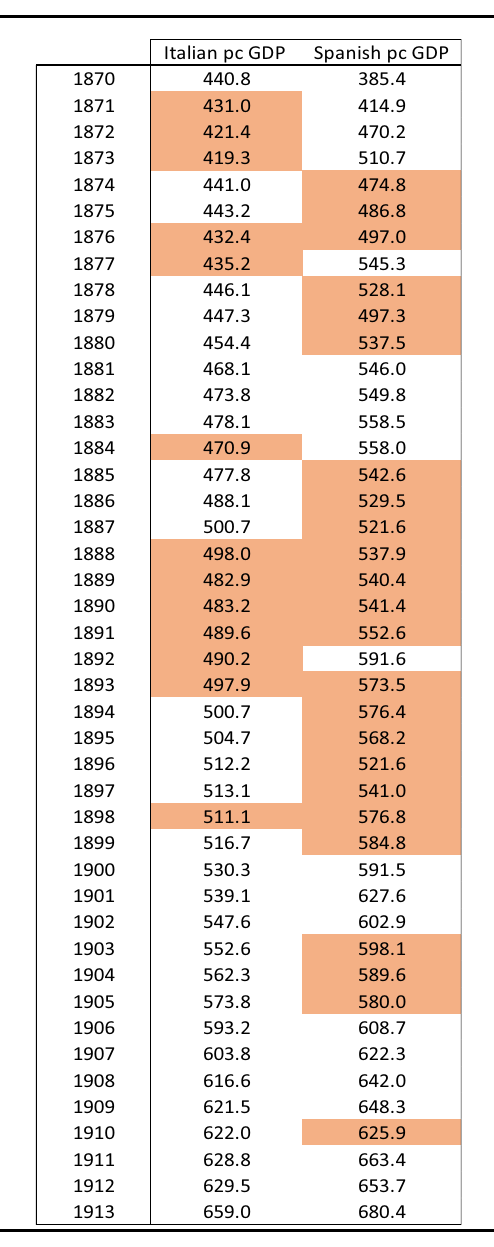
Table 2: Reductions in real pc GDP for Spain ( in pesetas ) and Italy ( in liras